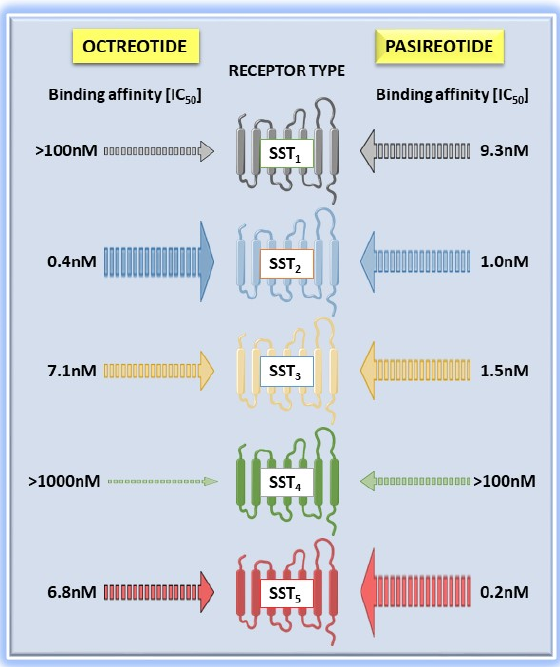
Figure 2. Octreotide and pasireotide binding affinity toward human somatostatin receptor subtypes.